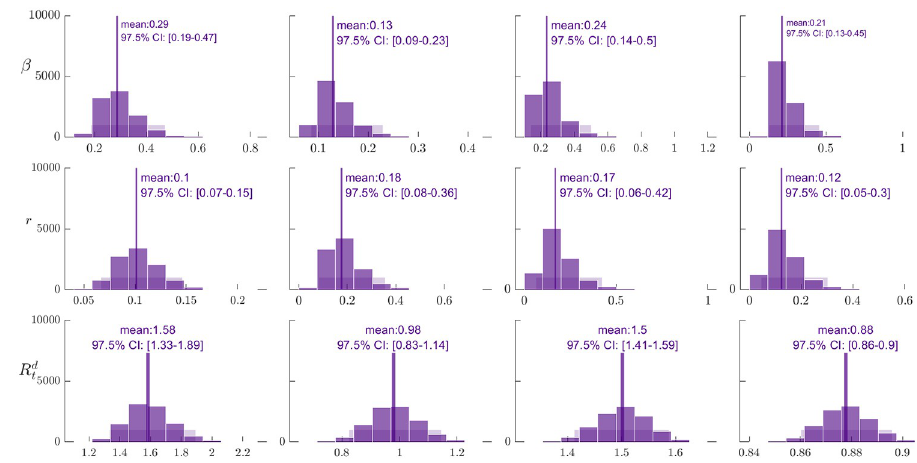
Fig 4. The histograms obtained from the parametric bootstrapping approach. These show the empirical distributions of the estimated parameters β and r , including R 0 for (from up to down) Q1, Q2, Q3, and Q4 estimations, respectively. We characterized the empirical distributions using 10,000 Bootstrap realizations assuming a Poisson error structure.